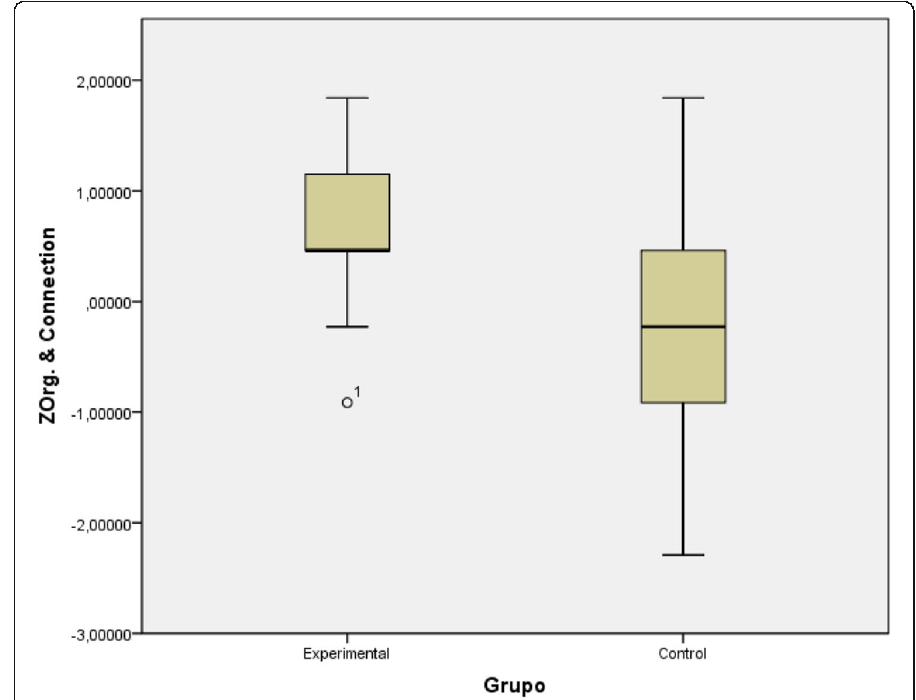
Fig. 4 Box-and-whisker plot of post-treatment progress in organising and linking ideas in both groups